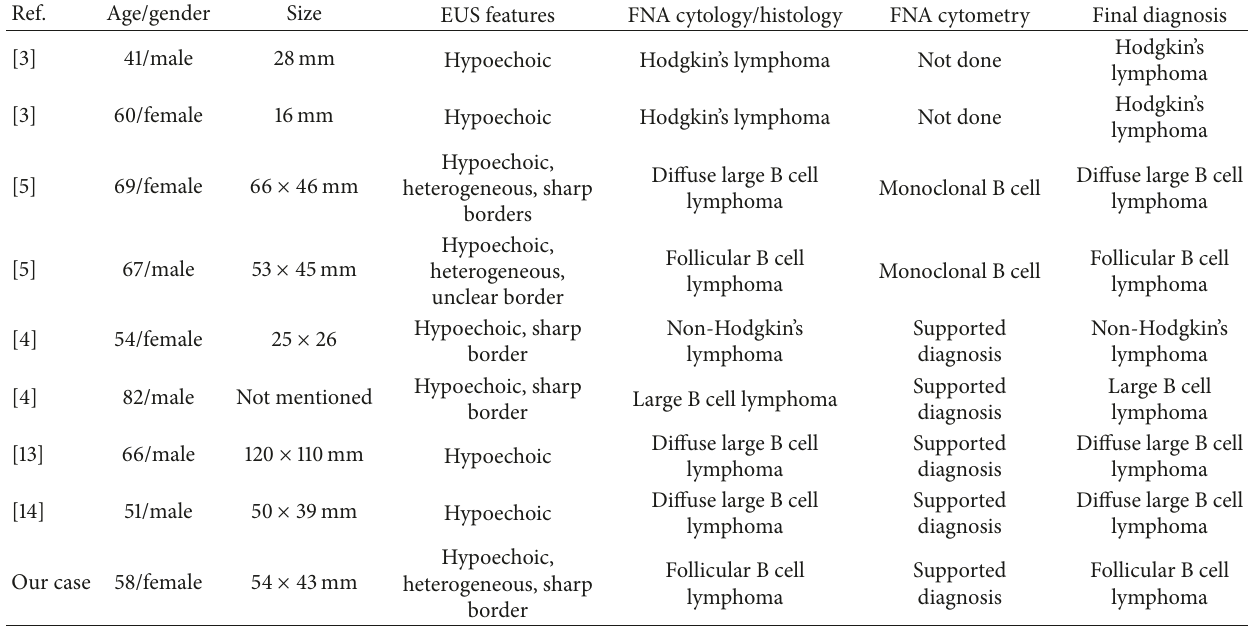
Table 1: Splenic lymphoma cases and associated findings via EUS-FNA. Ref.